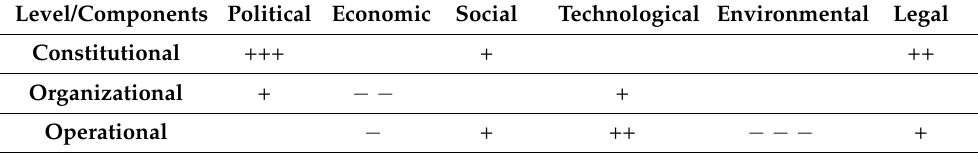
Table 2. Intervention